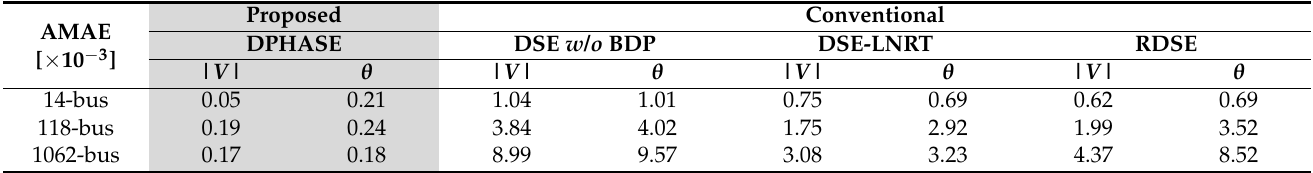
Table 11. Comparison of the AMAEs for the corrupted SCADA data.